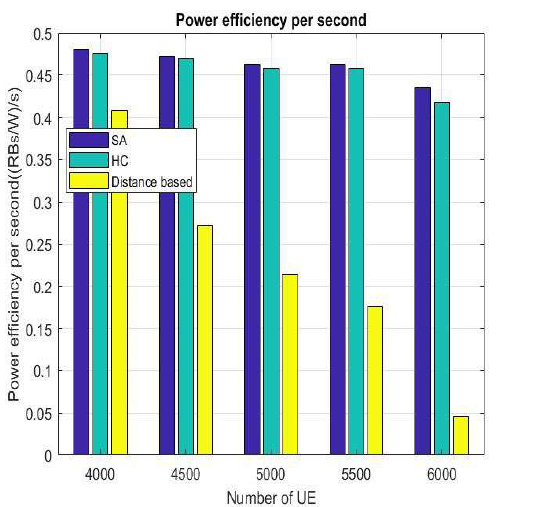
Figure 14. Power efficiency per second for number of different VUEs.